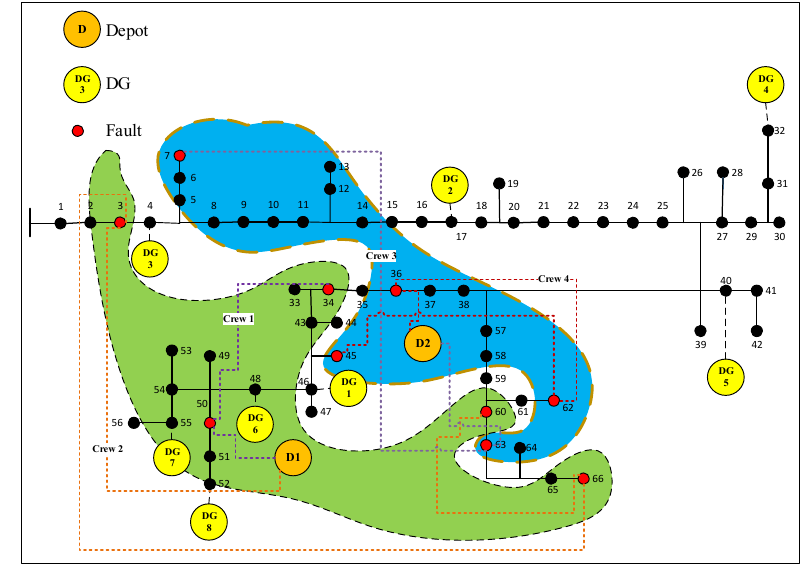
Figure 11. RRC schedule for Iranian 66 bus power distribution feeder.